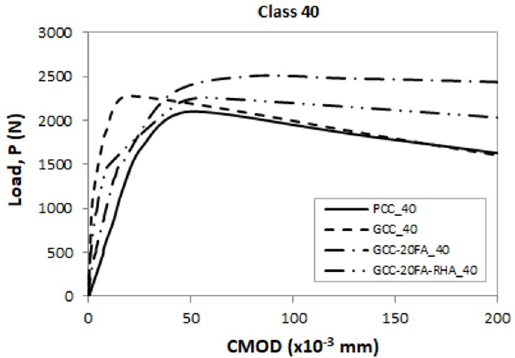
Figure 2. Variation of load with CMOD to 25 MPa strength class of concrete for all matrices studied.